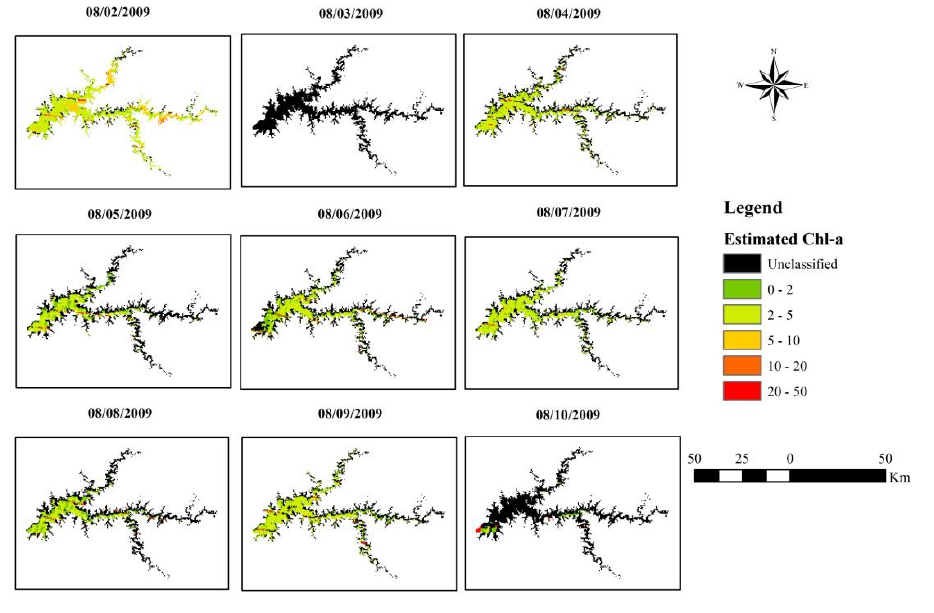
Figure 6. Estimated chl- a distribution in the Itumbiara Reservoir from